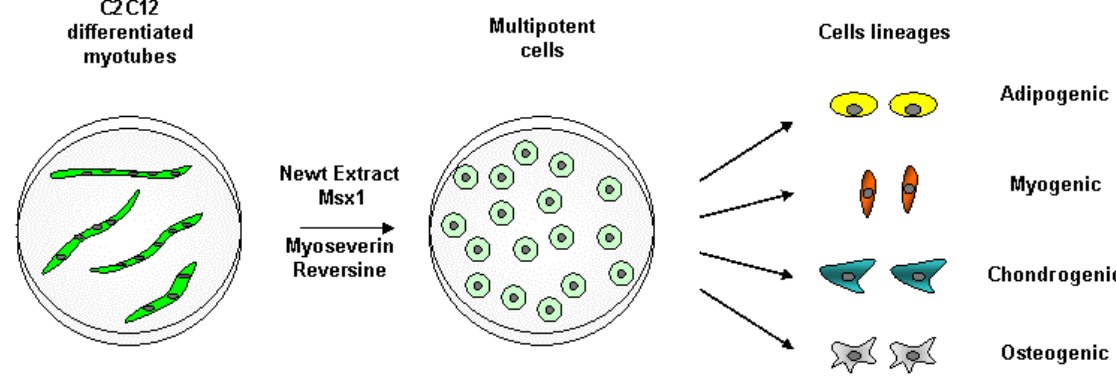
FIGURE 2. C2C12 myotubes dedifferentiate into multipotent progenitor cells. Differentiated C2C12 myotubes undergo dedifferentiation and fragment into mononucleate cells in response to newt extract[83], msx1 expression[42], myoseverin[91], or reversine[92]. The mononucleated cells generated are multipotent and were shown to redifferentiate into cells expressing adipogenic, myogenic, chondrogenic, or osteogenic